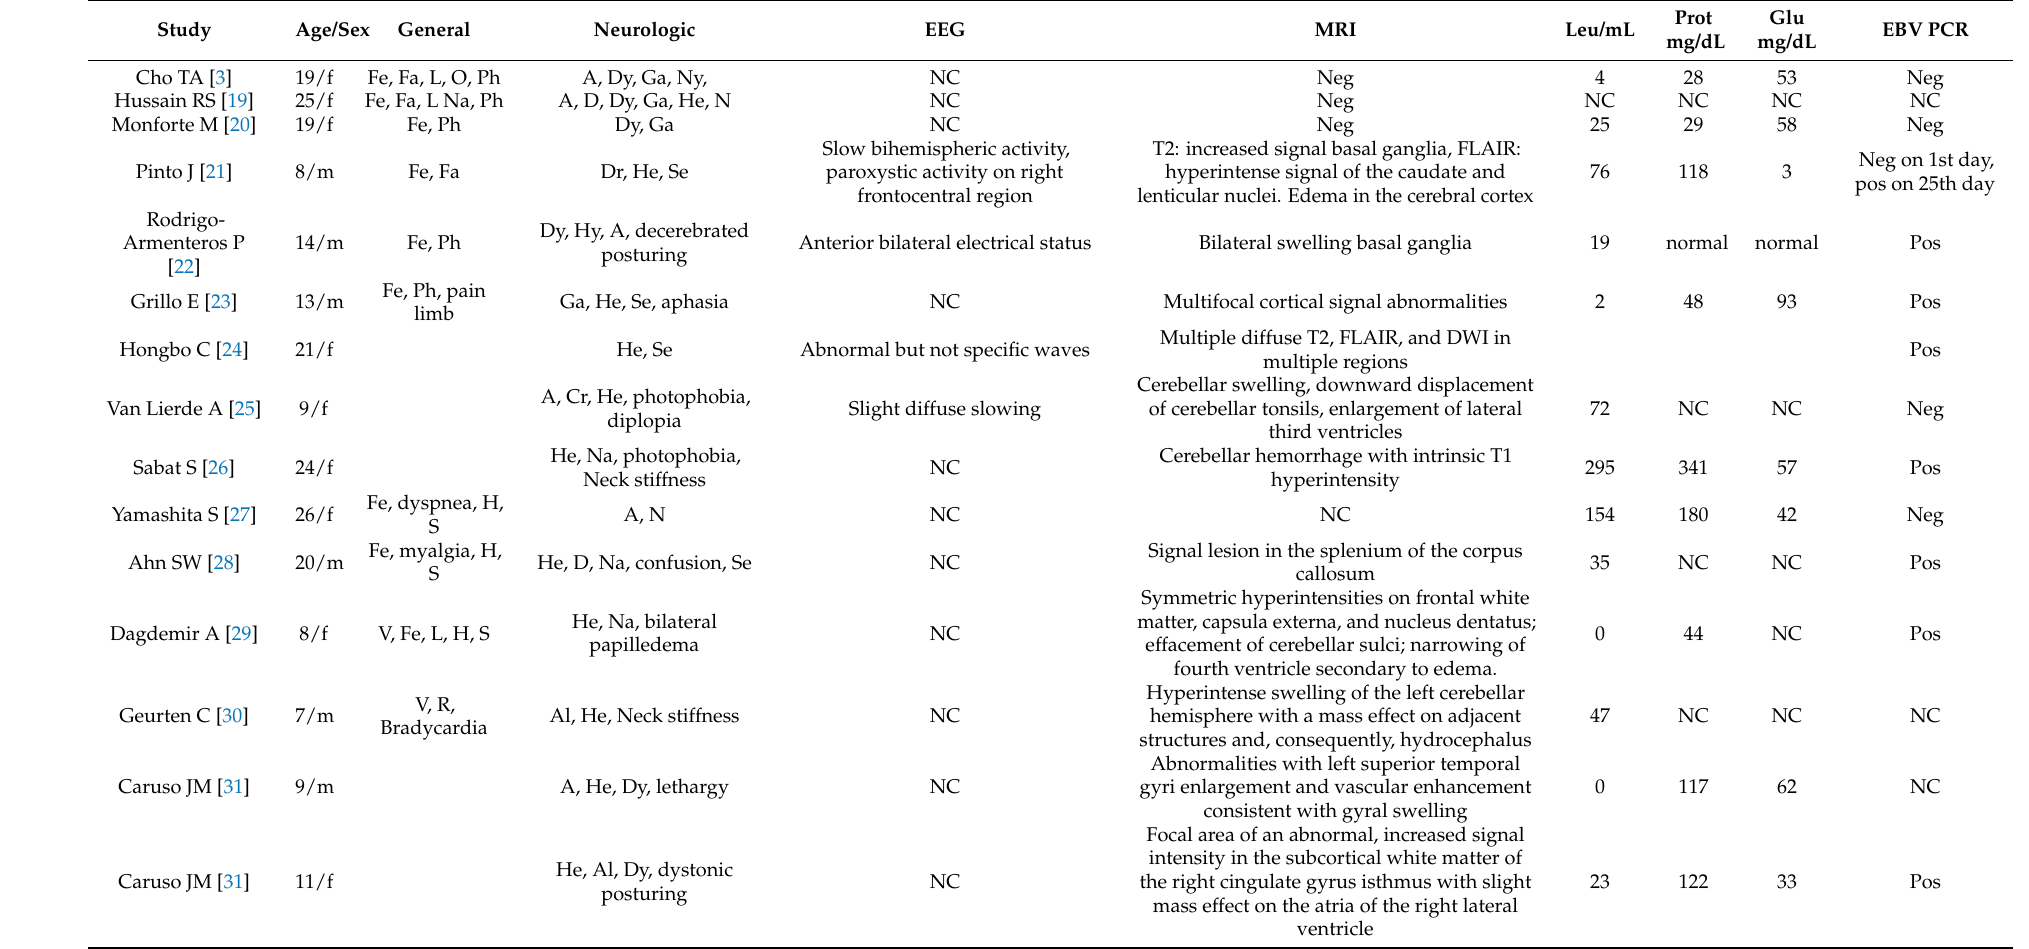
Table 1. Main characteristics related to neurological involvement during EBV infection in published pediatric and adult